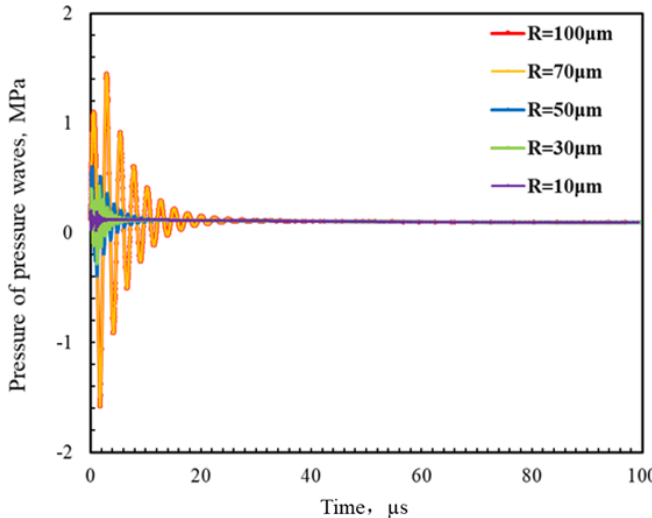
Figure 13. Change in microsecond-scale pressure waves with different d of microbubbles.